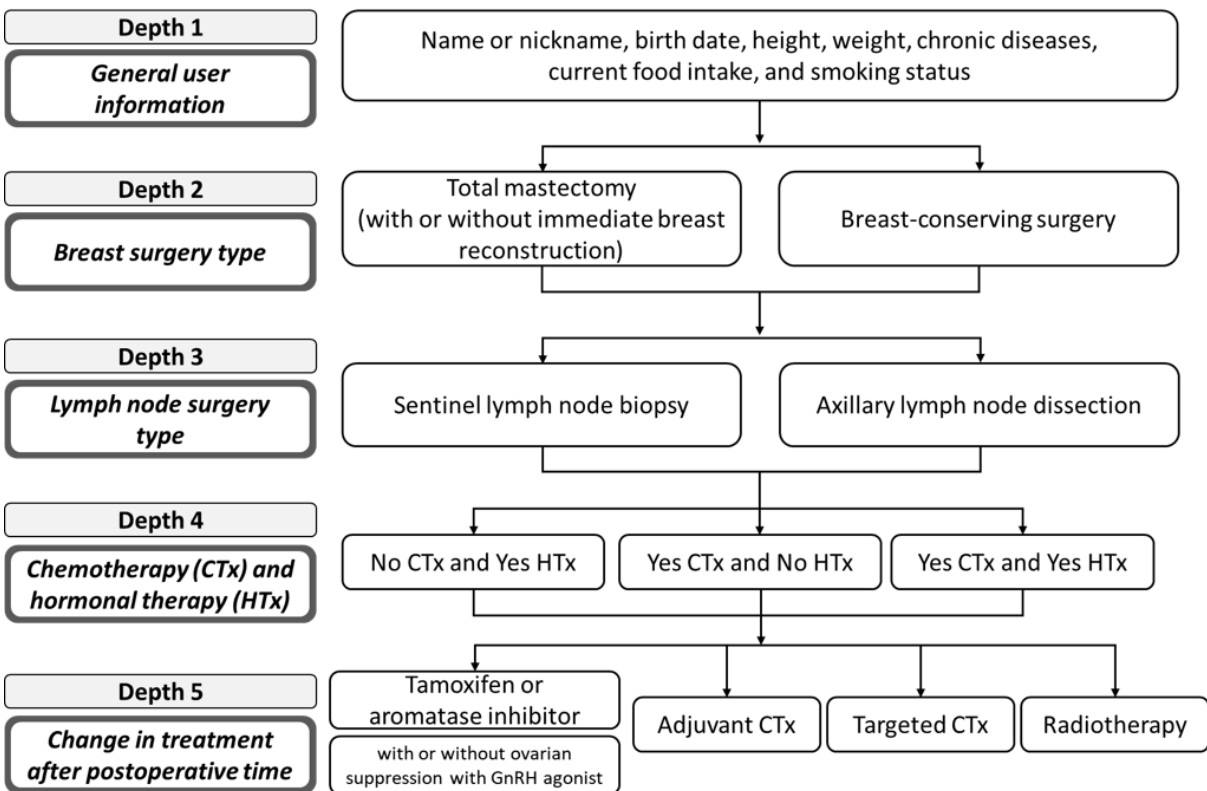
Figure 1. Classification system of user information for the algorithms for personalized